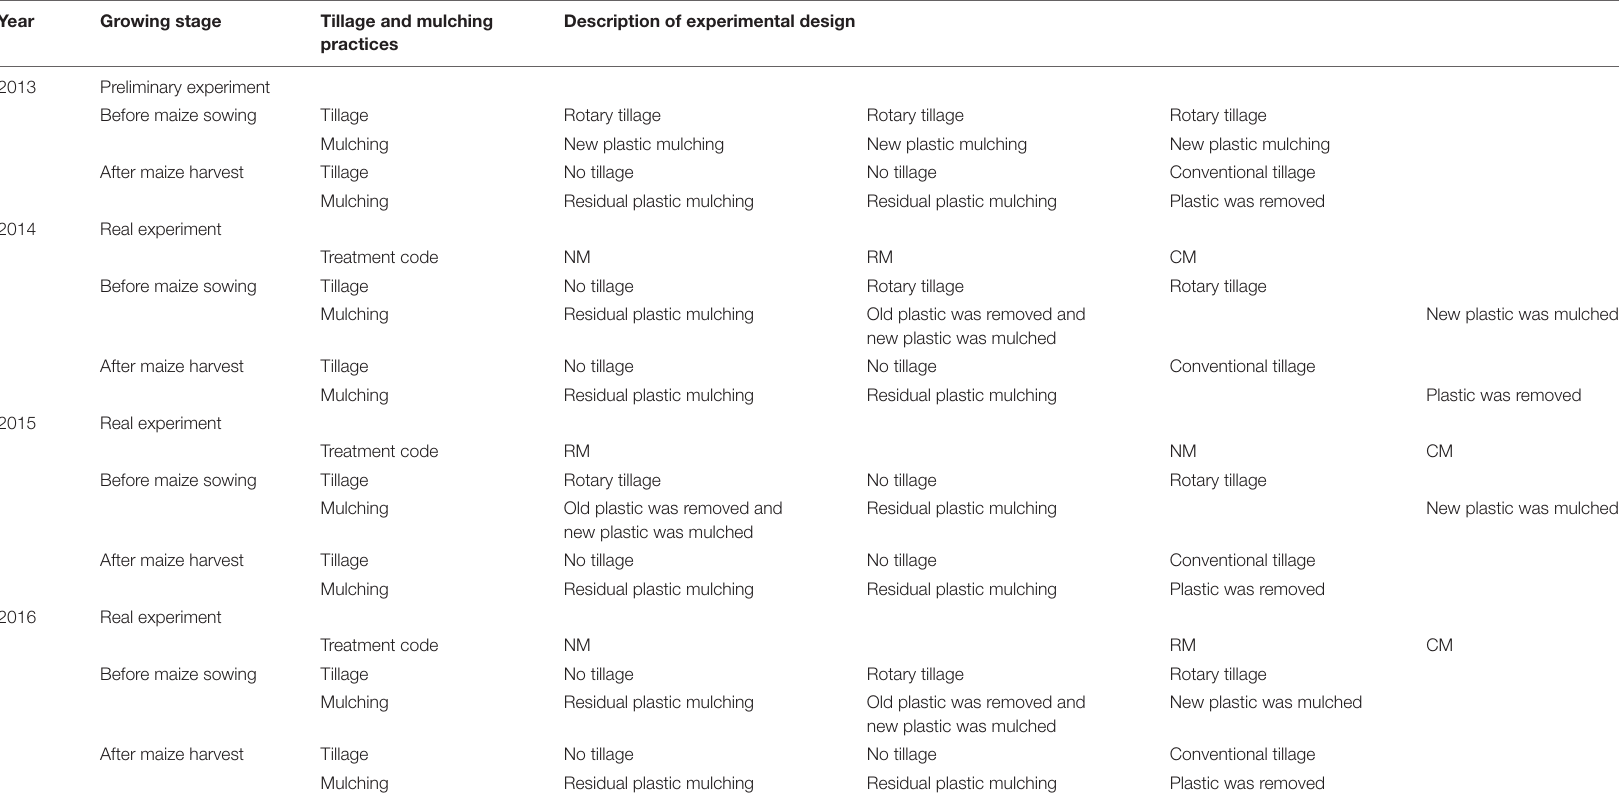
TABLE 1 | Yearly calendar diagram, which sets out the annual cycle of tillage and plastic practices for maize cultivation, at Wuwei Experimental Station, northwestern China, 2013–2016. Year Growing